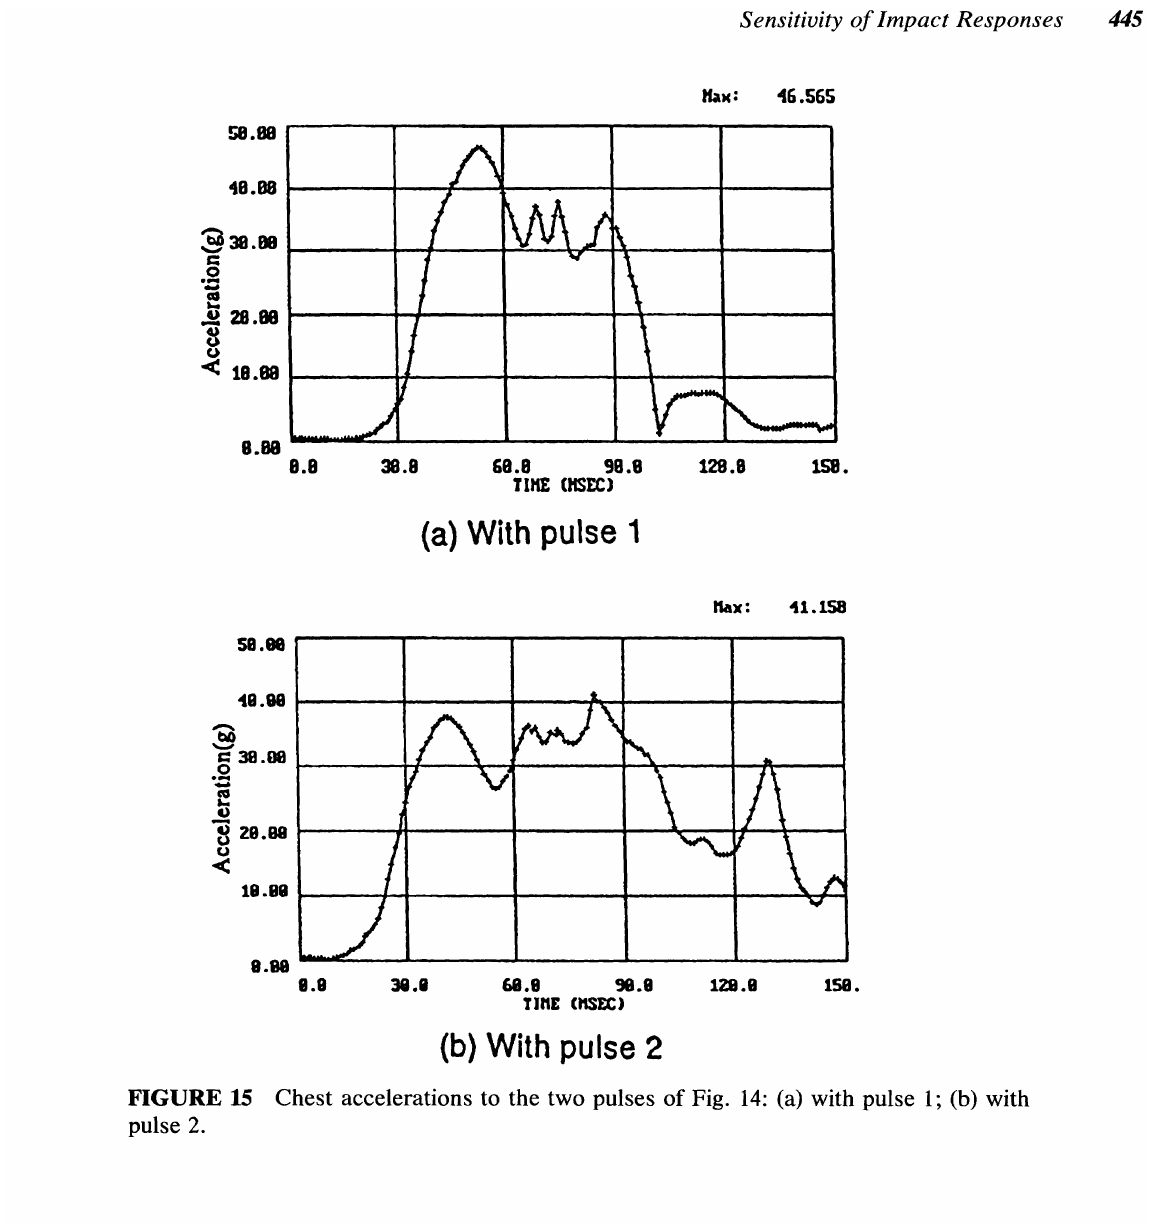
FIGURE 15 Chest accelerations to the two pulses of Fig. 14: (a) with pulse 1; (b) with pulse